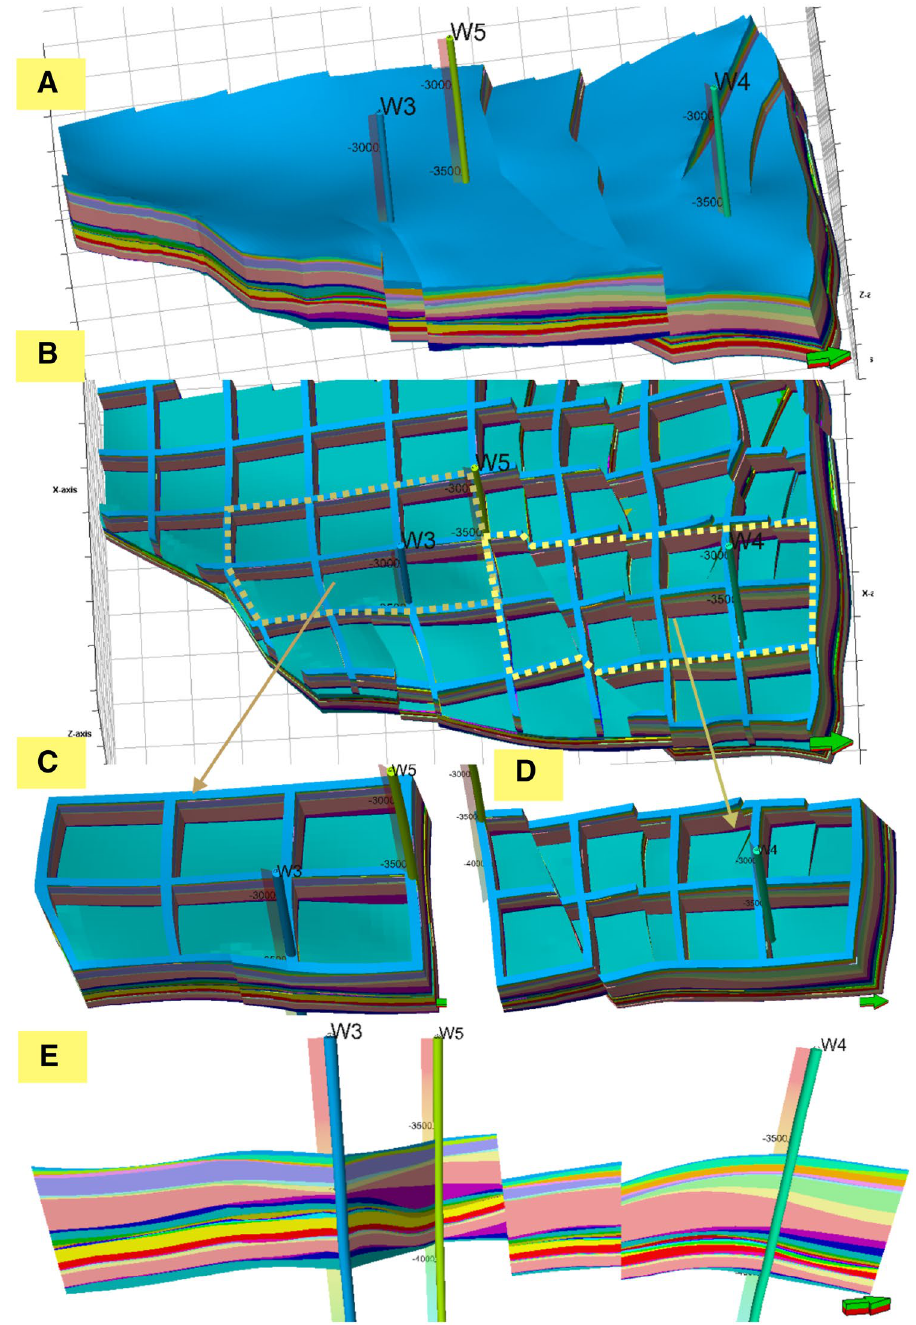
Fig. 6 3D geological model of the study area, showing the structural model including the fence model and cross-well profile. a 3D regional geologi- cal model of the study area; b three-dimensional structural fence model of a at X -axis (1, 1, 10), Y-axis (1, 1, 10), and Z -axis (13, 27, 27); c , d zoomed-in views of the left black boxes in b at X -axis (23, 78, 1) and Y -axis (45, 45, 1), X -axis (34, 45, 1) and Y -axis (56, 1, 1), respectively, showing a detailed distribution pattern of structural model; e through well structural sections, showing the spatial stratigraphic distribution between wells in each